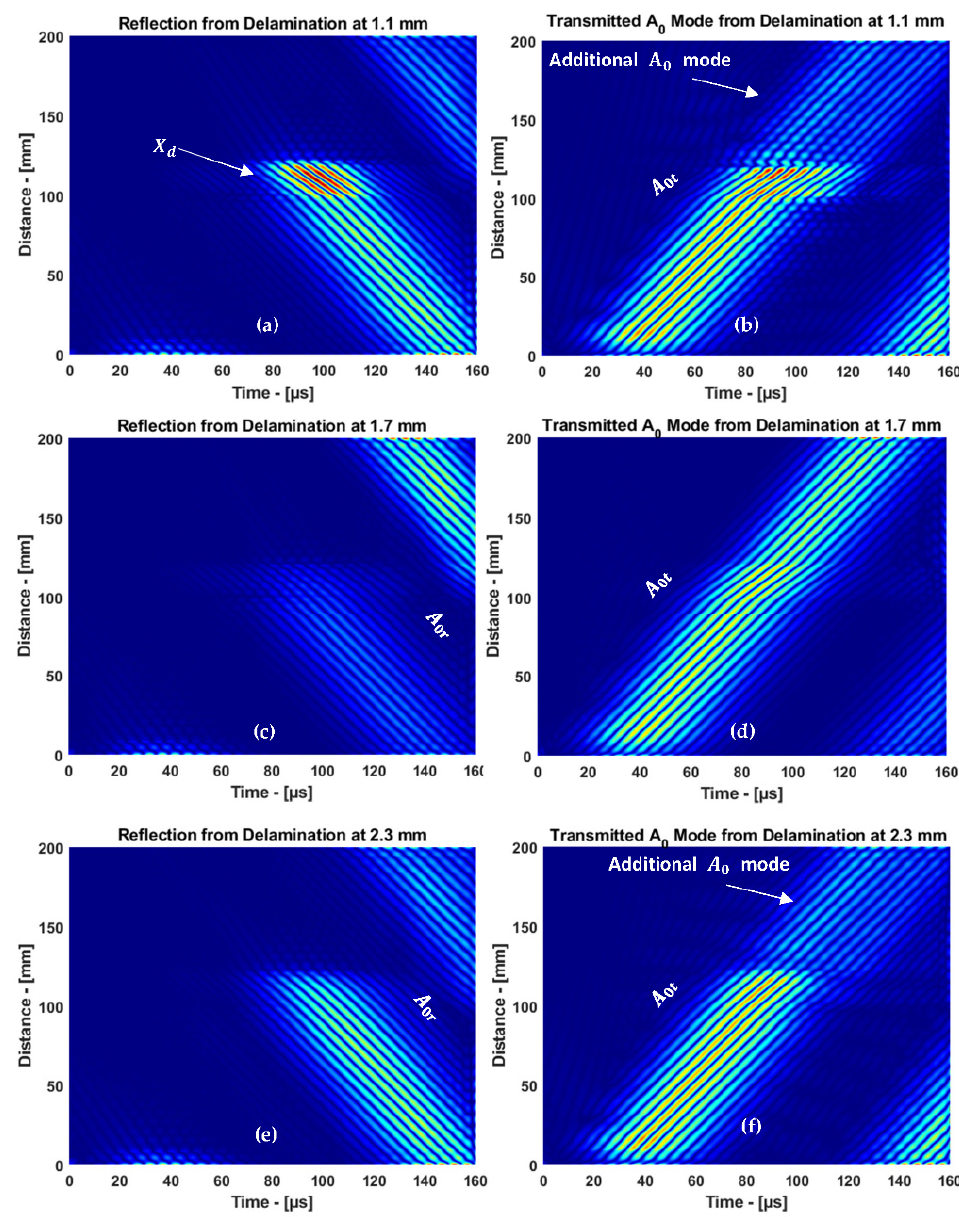
Figure 13. The reflected and transmitted A 0 mode through delamination: ( a , b ) 1.1 mm, ( c , d ) 1.7 mm, and ( e , f ) 2.3 mm.